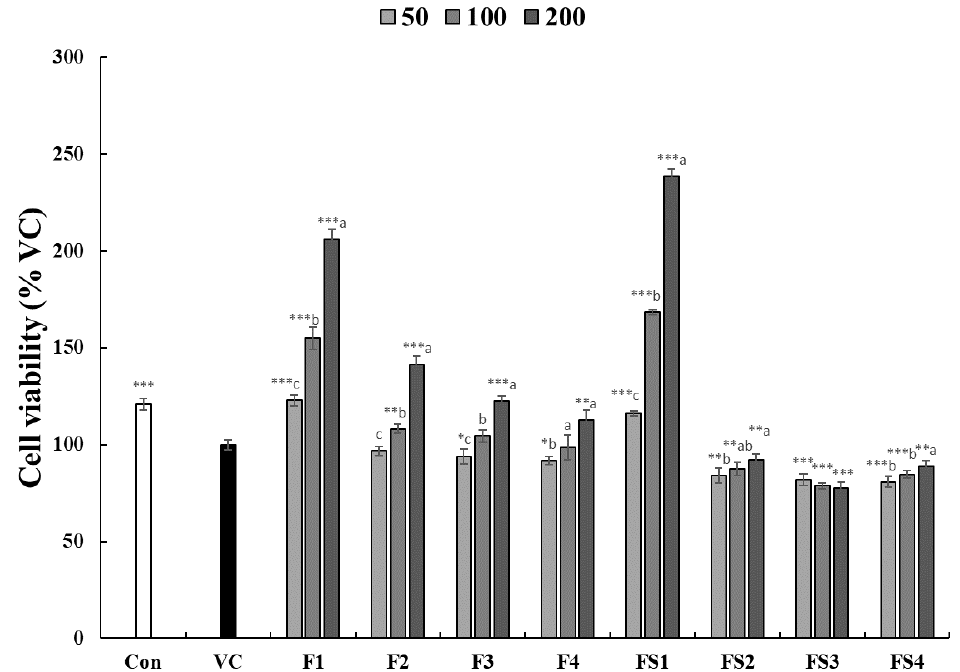
Figure 2. Effect of Cornus officinalis fruit extracts (50, 100, and 200 µg/mL) on 3T3-L1 preadipocyte viability, as revealed by MTT assay. The 3T3-L1 cells were incubated for 24 h with C. officinalis fruit extracts. Data are means ± SD. ( n = 4). VC, vehicle control (DMSO). * p < 0.05; ** p < 0.01; *** p < 0.001. Significant difference by the two-sample Student’s t -test between non-treated (VC) and treated cells. Different small letters on the bars indicate a significant difference ( p < 0.05) among concentrations of the same samples. Samples are listed in Table 1.